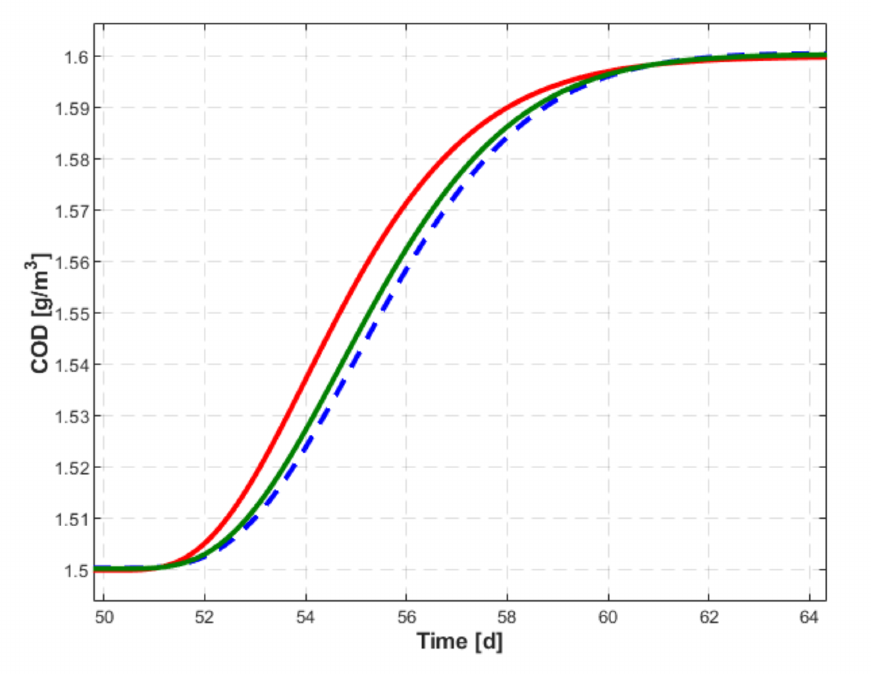
Figure 19. Evolution of the controlled variable for (cid:101) ω = 3.5 [ rad/d ] (green) in relation to the set point (red). For (cid:101) ω = 2.5 [ rad/d ] the controlled variable is represented with dashed blue line.